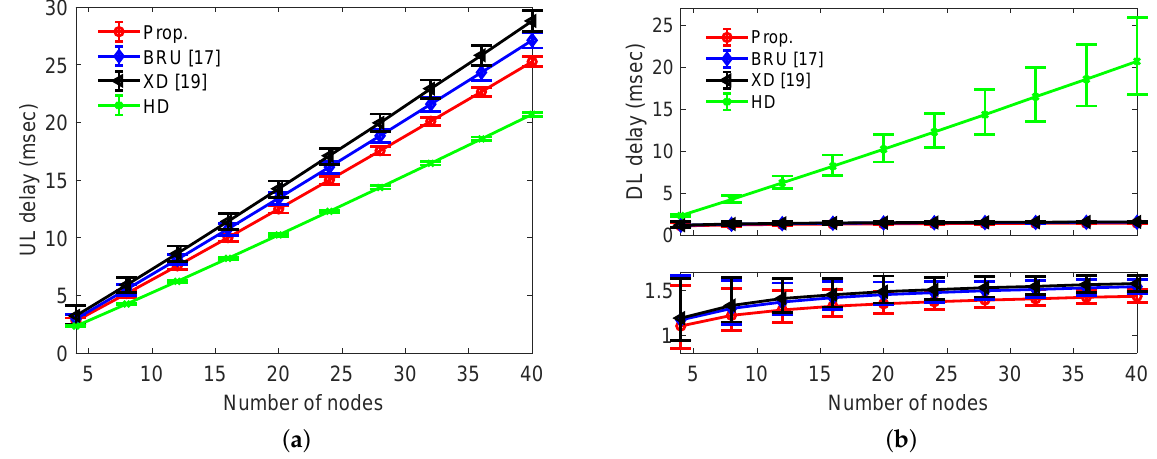
Figure 4. Delay based on the number of nodes (SIC = 110 dB) for ( a ) UL and ( b ) DL.